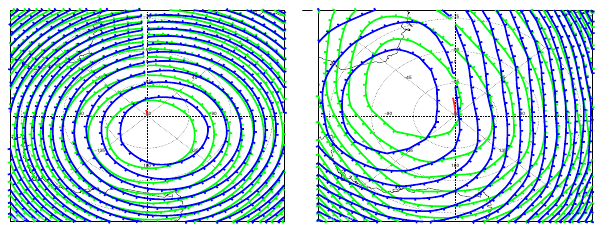
Figure 3. (Left) Results of the GROGRAT “climatological” run for the wave observed on 6 August 2004 using background pressures, temperatures, and horizontal winds reconstructed from NRLMSISE-00 and HWM-93. (Right) Results of the GROGRAT run for the same wave using an atmosphere constructed from ECMWF Reanalysis below 50km altitude and NRLMSISE-00 and HWM-93 between 50 and 100km altitude. The two contours in each panel represent geopotential heights at 3mbar (blue) and 10mbar (green), and the red line in each panel represents the wave ray path.